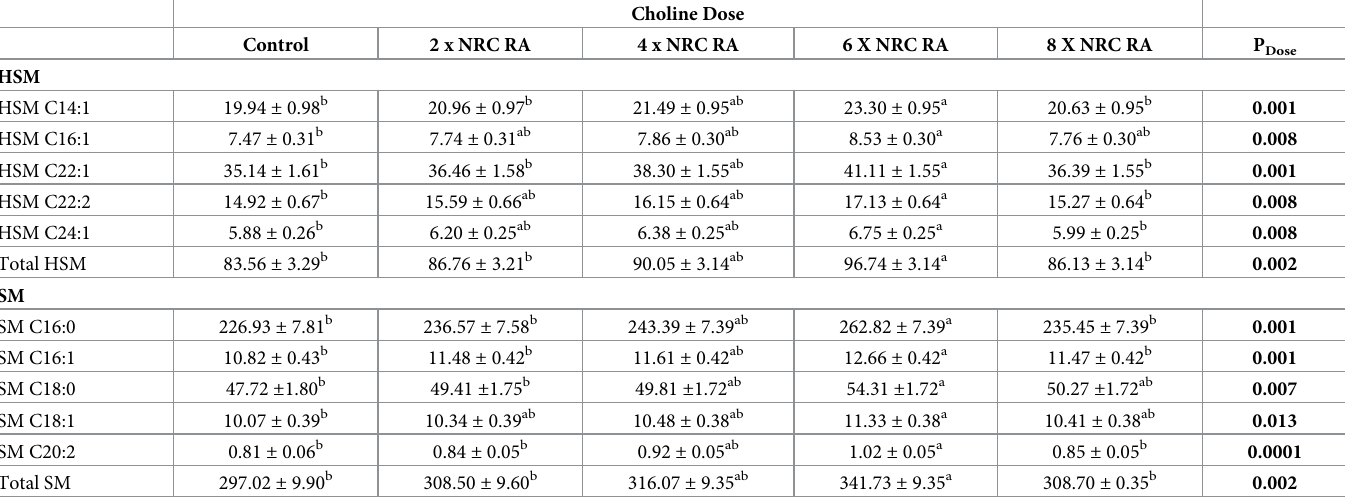
Table 7. Mean serum concentrations ( μ M) of HSM and SM determined by DI-MS in overweight cats (n = 14) receiving control (no additional choline supplementa- tion, 1.2 x NRC RA, 77 mg/kg BW 0.67 ), choline at 2 x NRC RA (126 mg/kg BW 0.67 ), 4 x NRC RA (252 mg/kg BW 0.67 ), 6 x NRC RA (378 mg/kg BW 0.67 ), and 8 x NRC RA (504 mg/kg BW 0.67 ), in a 5 x 5 Latin square design for 3-week periods.